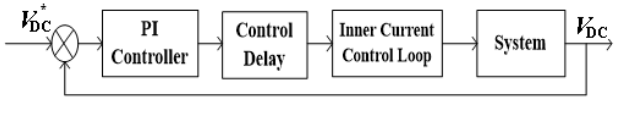
Fig. 8. Block diagram representation of the DC voltage control loop.